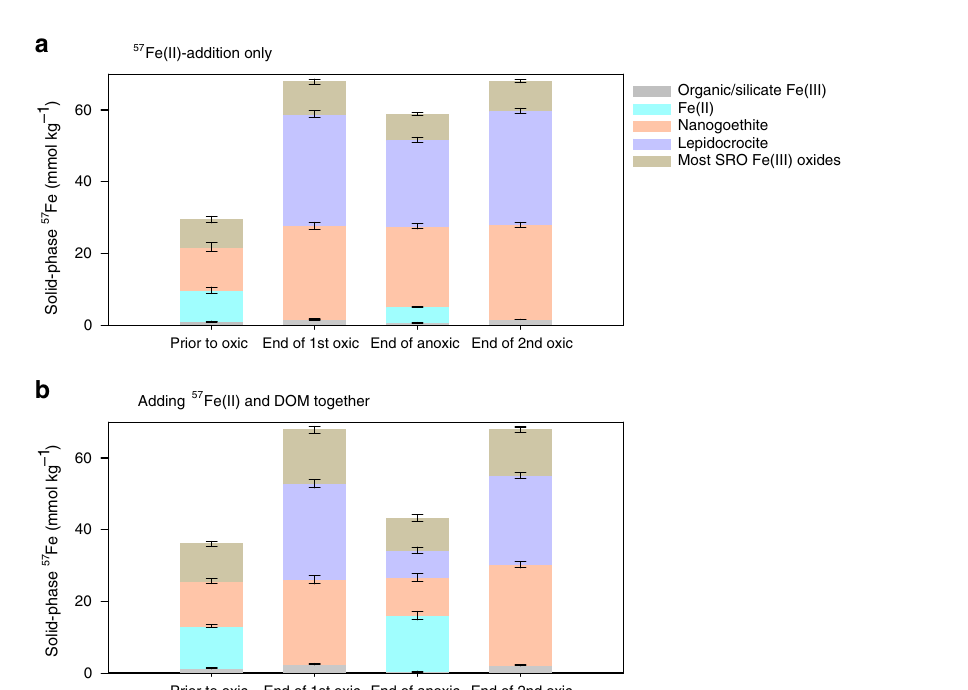
Fig. 3 Solid-phase speciation of added 57 Fe. 57 Fe partition was calculated from respective Mössbauer spectra (corrected to exclude the signal from the native soil Fe) for the ( a ) 57 Fe-only and ( b ) 13 C-DOM- 57 Fe addition treatments, prior to the oxic phase (day 1) and at the end of the 1st oxic (day 6), anoxic (day 17) and 2nd oxic (day 22) phases. Error bars represent standard errors associated with Mössbauer data modeling (see Supplementary